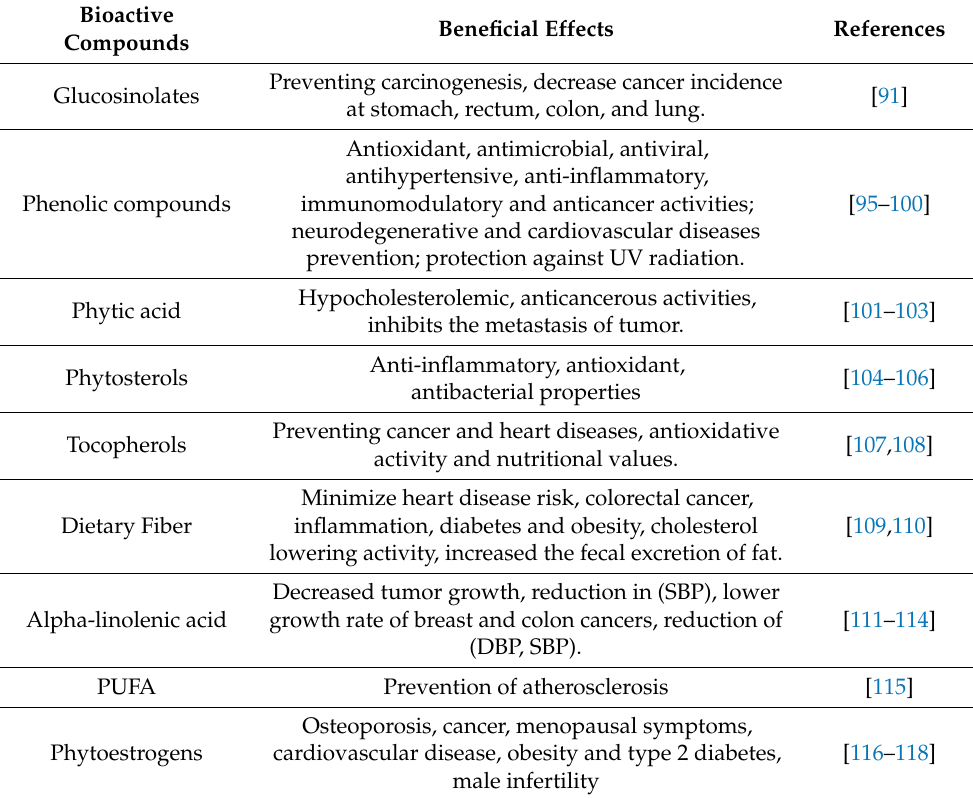
Table 4. Bioactive compounds and their health beneficial